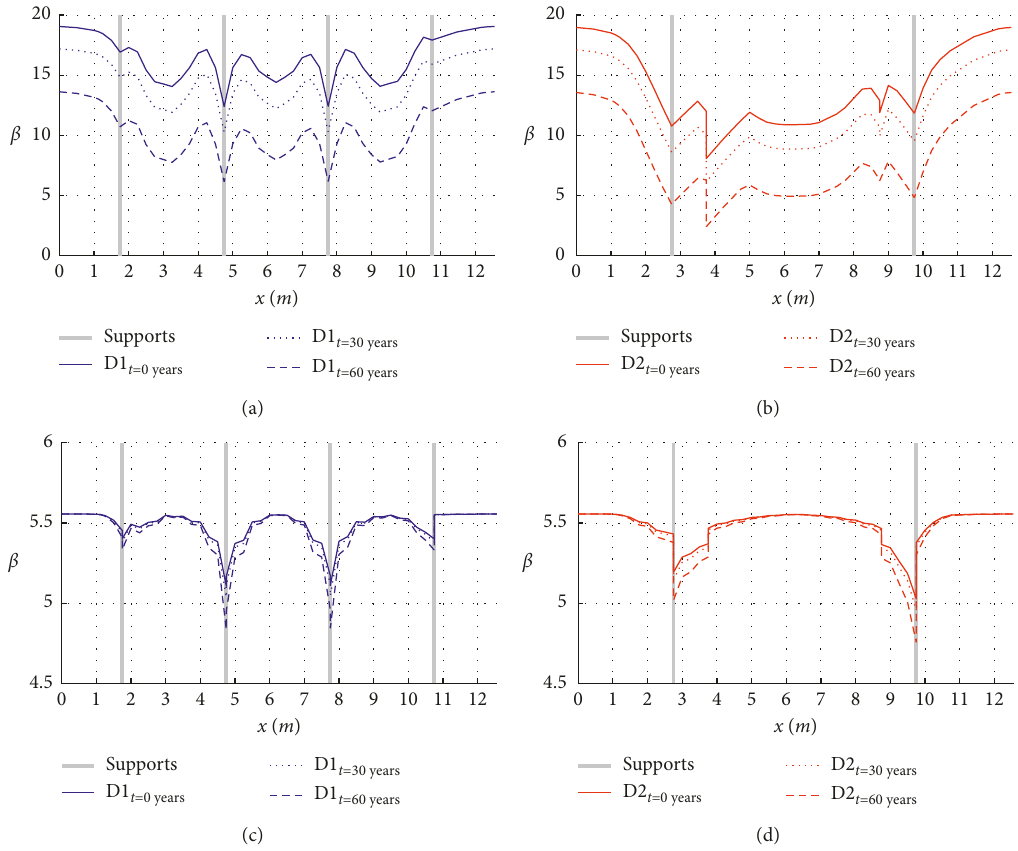
Figure 12: Reliability index for the deck for different lifetimes.